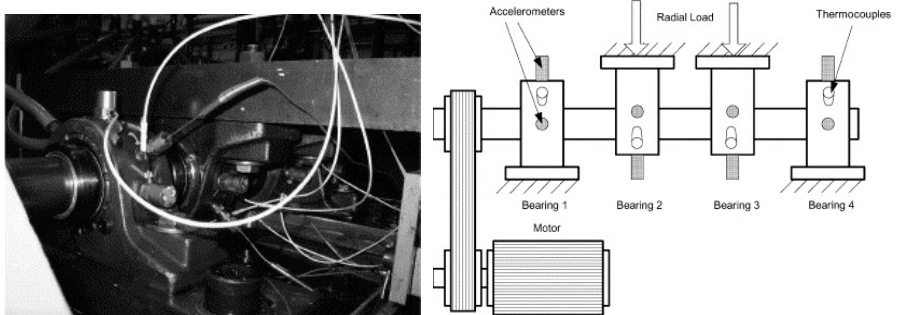
Figure 8. Bearing test rig for analyzing natural bearing failure.